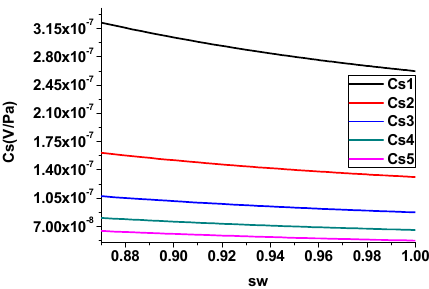
9 of 13 Figure 5. Influence of salinity on streaming potential coupling coefficient (bubbly flow). Figure 6 investigates the effect of pore fluid viscosity on the streaming potential cou- pling coefficient of the capillary in the bubbly flow case. The viscosity is taken as 0.001